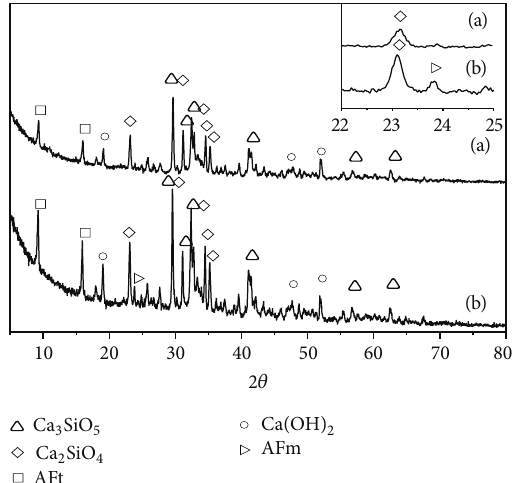
Figure 12: XRD of cement paste (a) without NS and (b) with NS30/4.0 at 3